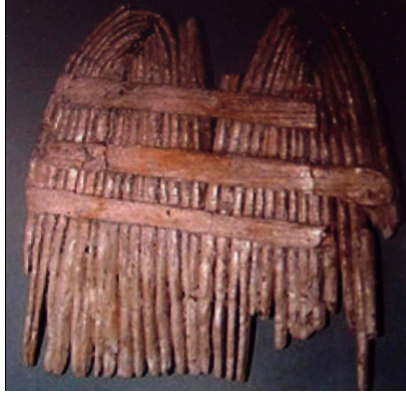
Figure 1. Image of the Universe 400,000 years after the Big Bang.